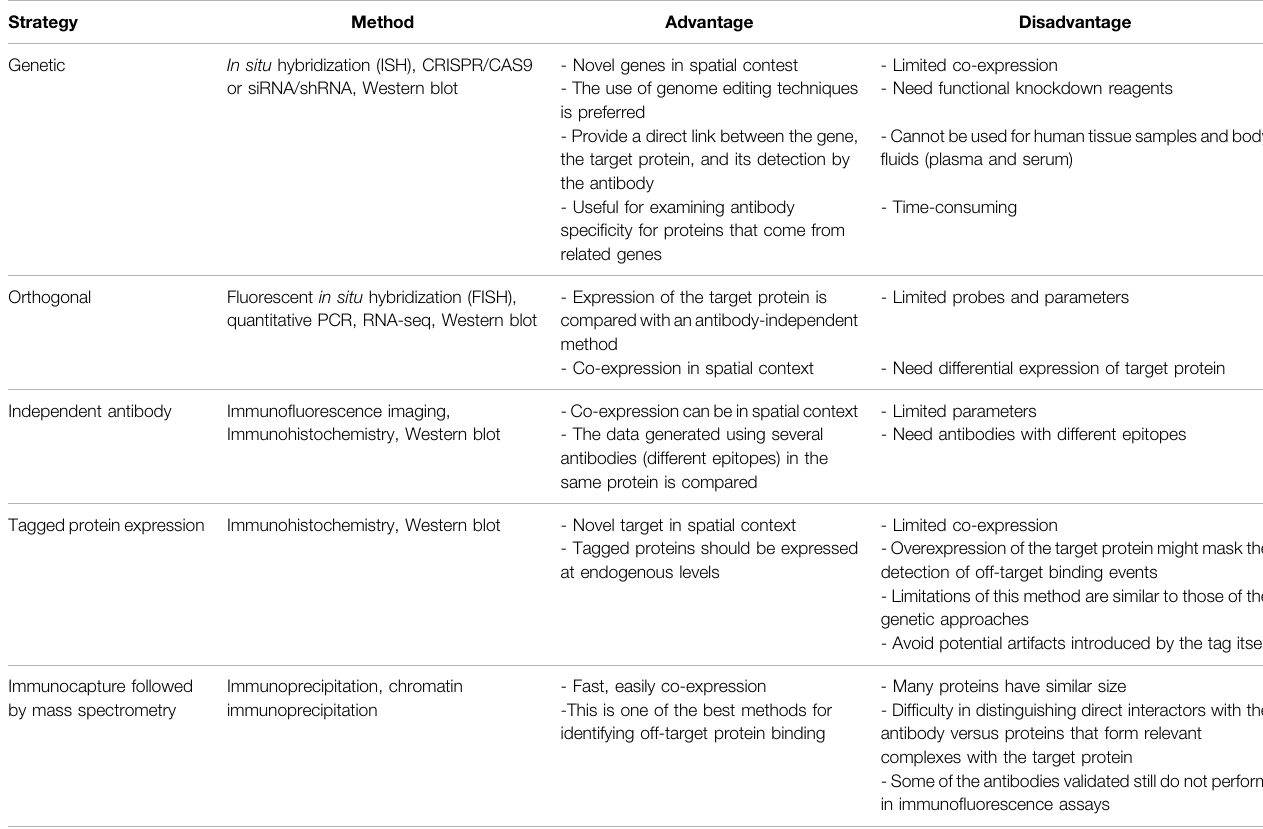
TABLE 2 | Strategies and methods for antibody/multiplex immuno fl uorescence panel validation. Strategy